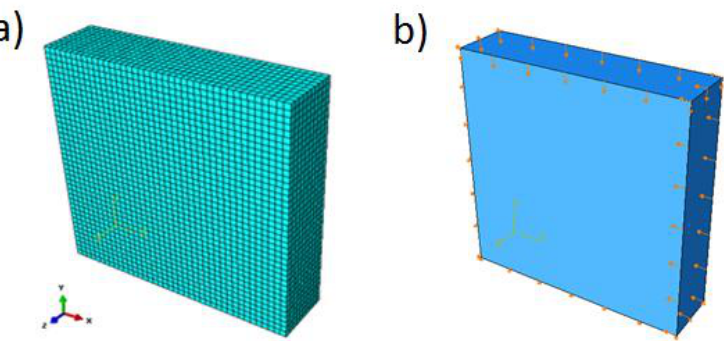
Figure 4. Setup for compression test: mesh ( a ) and boundary conditions ( b ).